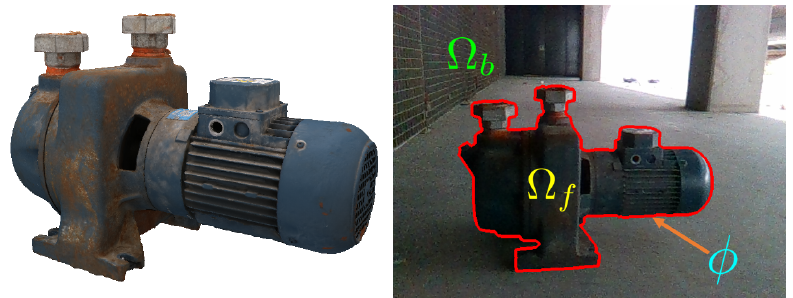
Figure 6. Left Image: 3D model. Right Image: Initialization of the tracking method by projecting the 3D model on the 2D image captured by the camera for a certain pose G (see Equation (4)). The projected object contour determines the background, Ω b , and the foreground, Ω f